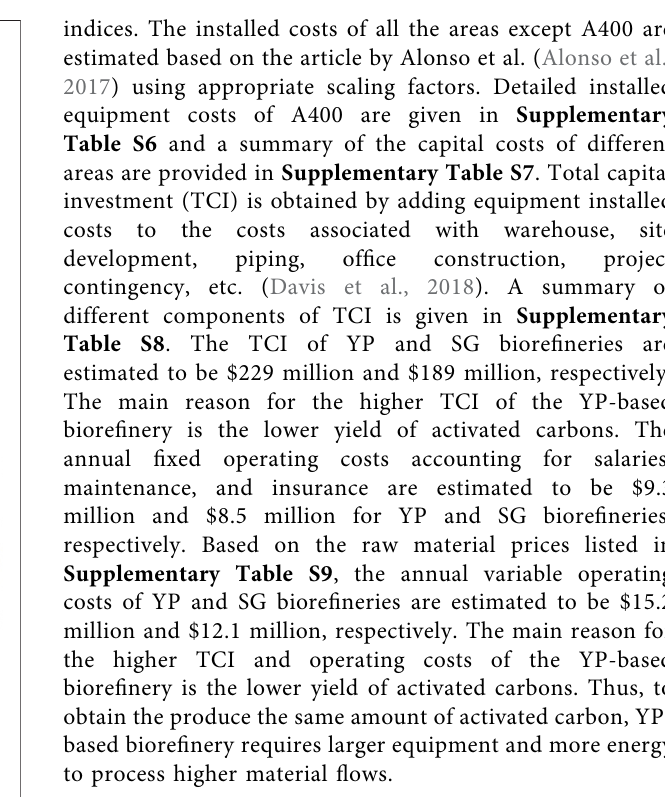
Frontiers in Energy Research |